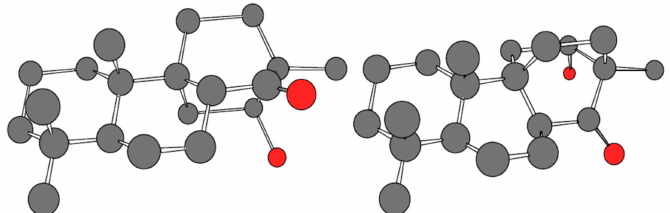
Figure 7. Three-dimesional structures of XIIa (left) and XIIb (right); red round indicates oxygen atom and grey one carbon